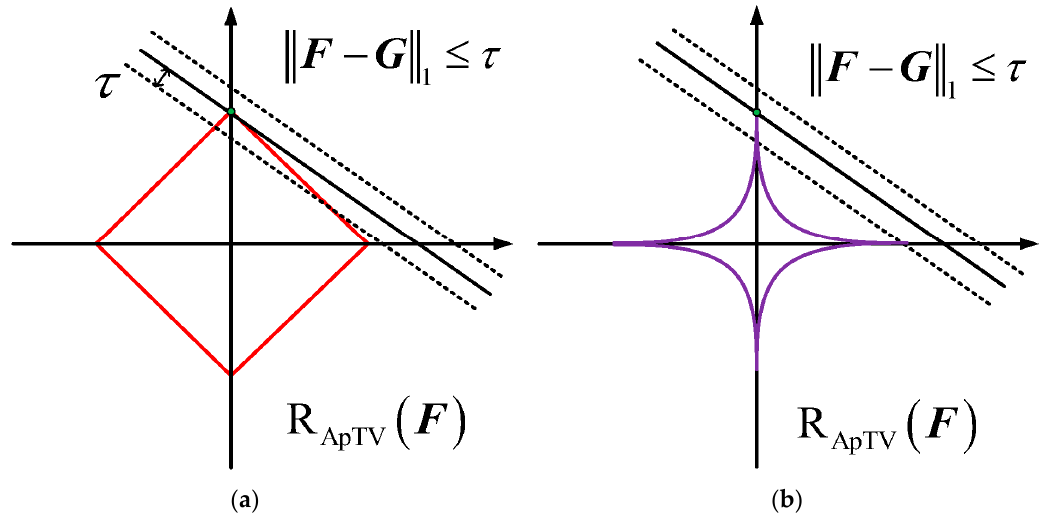
( ) R F : ( a ) p = 1; ( b ) 0 < p < 1. Figure 2. Feasible regions of R ( F ) : ( a ) p = 1; ( b ) 0 < p < ( ) ApTV ApTV R F : ( a ) p = 1; ( b ) 0 < p < 1. ApTV